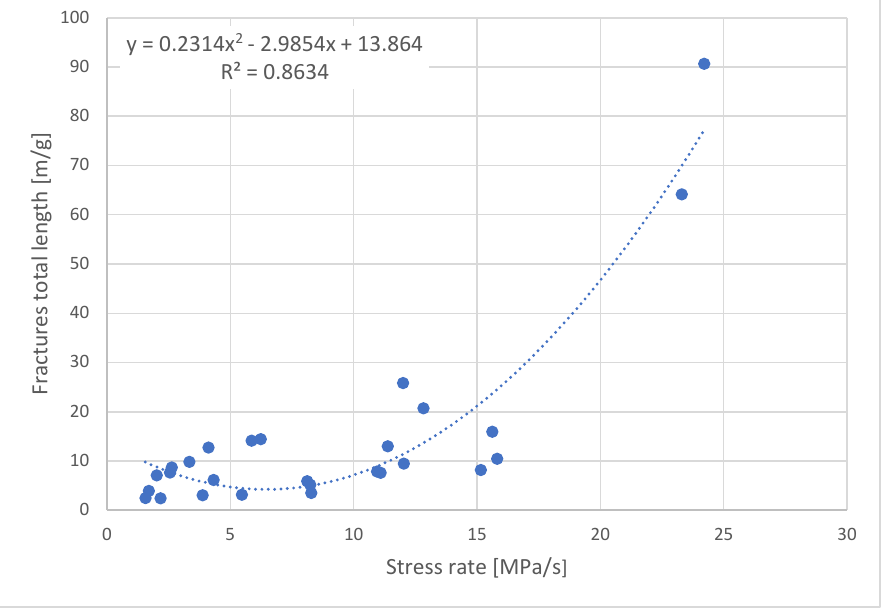
y = 0.2314x 2 - 2.9854x + 13.864 R² = 0.8634